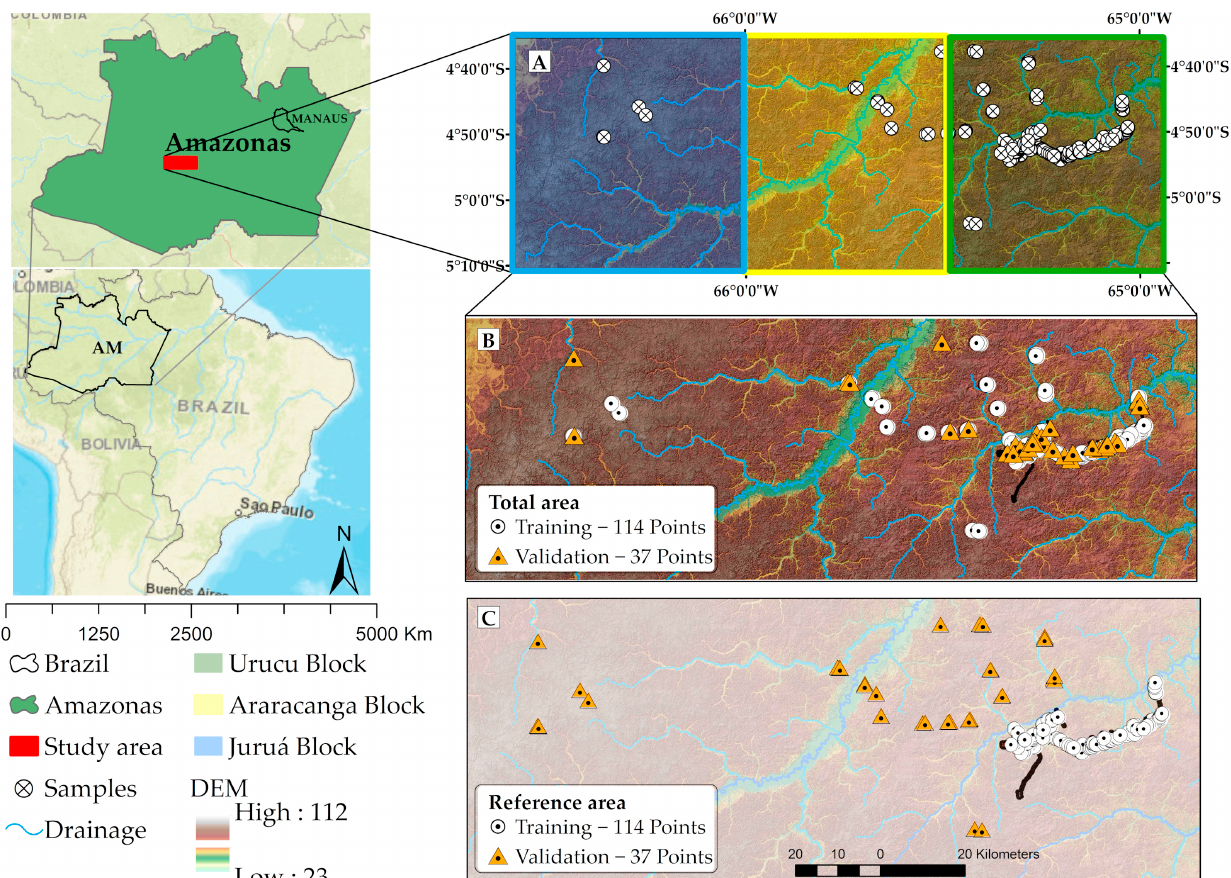
Figure 1. ( A ) Location of the study area in Central Amazon, Brazil; ( B ) Total area (TA) sampling, showing the 75% training and 25% validation random samples; and ( C ) Reference area (RA) sampling, with the 75% training samples concentrated at the Geólogo Pedro de Moura Support Base, and the 25% validation samples lying outside the RA.